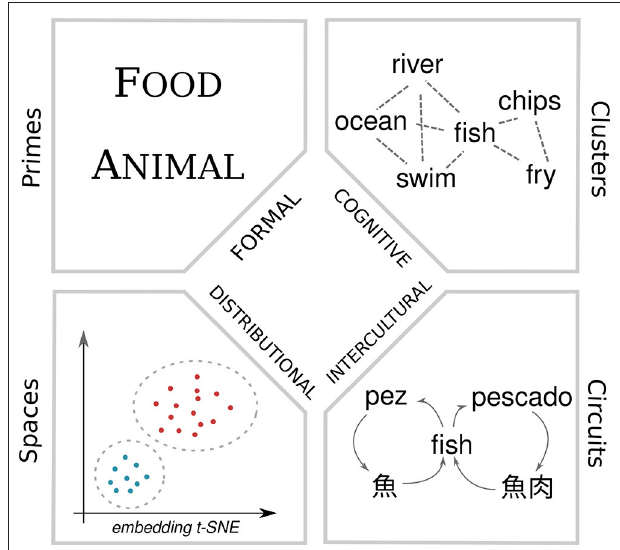
FIGURE 2 | Methodologies for making sense